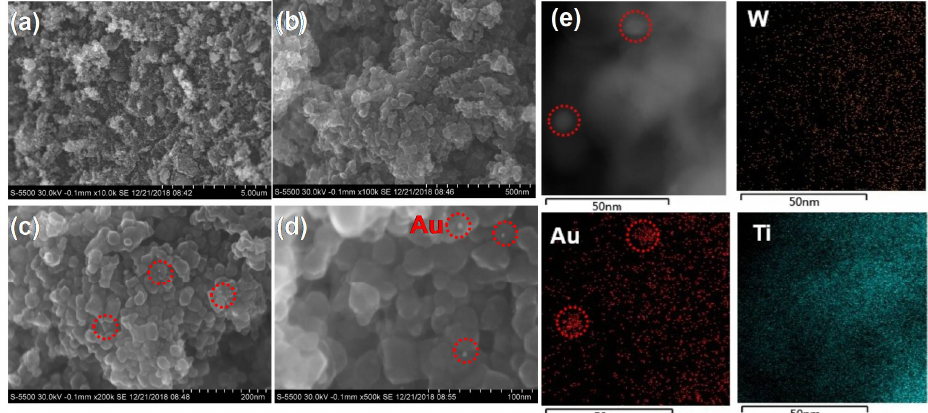
Figure 1. ( a ) The XRD patterns and ( b ) infrared spectra of the i AuPT and POM catalysts, and the standard cards for anatase (No. 21-1272) and rutile (No. 21-1276). Figure 2 exhibits the SEM images and elemental maps of Au, Ti, and W of the 0.25 AuPT catalyst. We found that the POM was dispersed onto the surface of TiO 2 (Figure 2a,b), and the TiO 2 NPs featured diameters of approximately 20–50 nm (Figure 2d). The Au NPs (Figure 2c–e, marked in red circles) were highly dispersed on the surface of TiO 2 and POM, and the typical size of the Au was estimated to be ca. 2–5 nm. The HR-TEM and EDX images further revealed that Au was homogeneously distributed on TiO 2 and POM , the elemental ratio of Co:W:Sn, which is about 1.1:11:1.3 (calculated by Table S1). For the composite AuPT catalyst, there were some good contacts in the interface of Au/TiO 2 and POM/TiO 2 , which may be favorable for the transfer of electrons and holes.